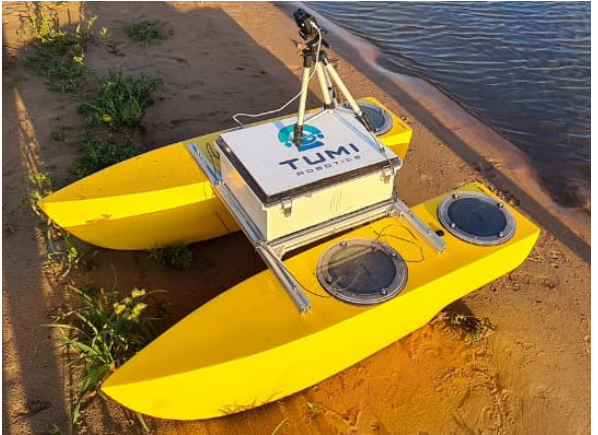
Figure 2. Autonomous Vehicles prototype used in [3] for the monitoring of Ypacaraí Lake. The vehicle has two separate motors and a battery that allows a stable speed of 2 m/s during 4 h of